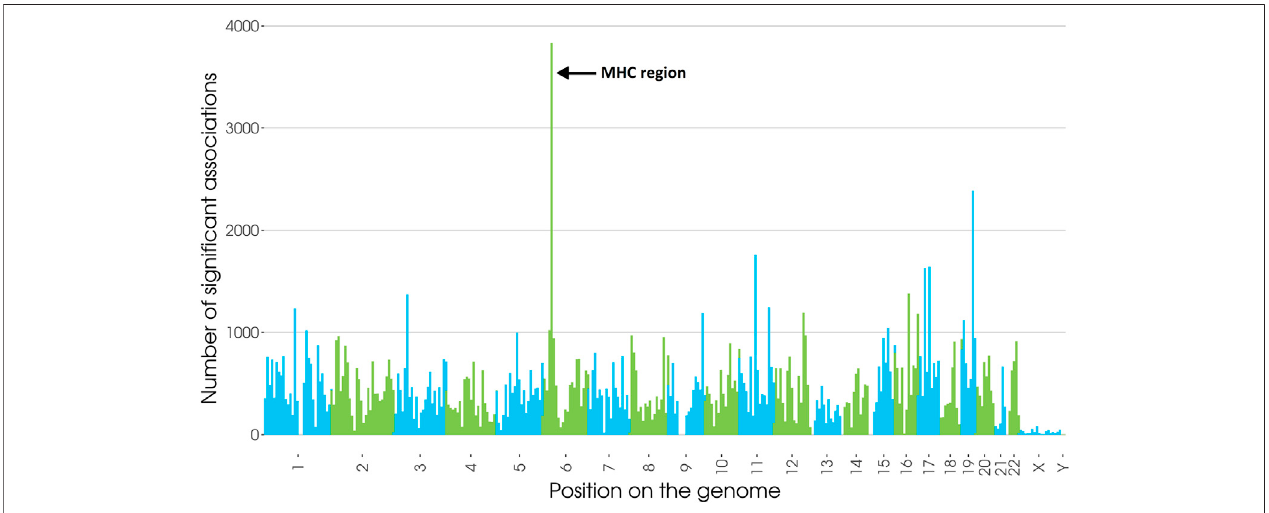
FIGURE 1 | Number of signi fi cant SNP associations to any trait or pathology from the GWAS catalog within the whole genome divided in 350 bins (inspired from Lenz TLet al.,2016(Lenzet al.,2016) &Kennedy et al., 2017(Kennedy et al.,2017)).4,080associationsfallin theextended MHCregion(25 – 34Mb, GRCh38), 2,784of which are located between 30 and 34 Mb where most HLA genes are found. Updated on January 14th, 2021.155,456 associations with p -value < 5 × 10 − 8 .